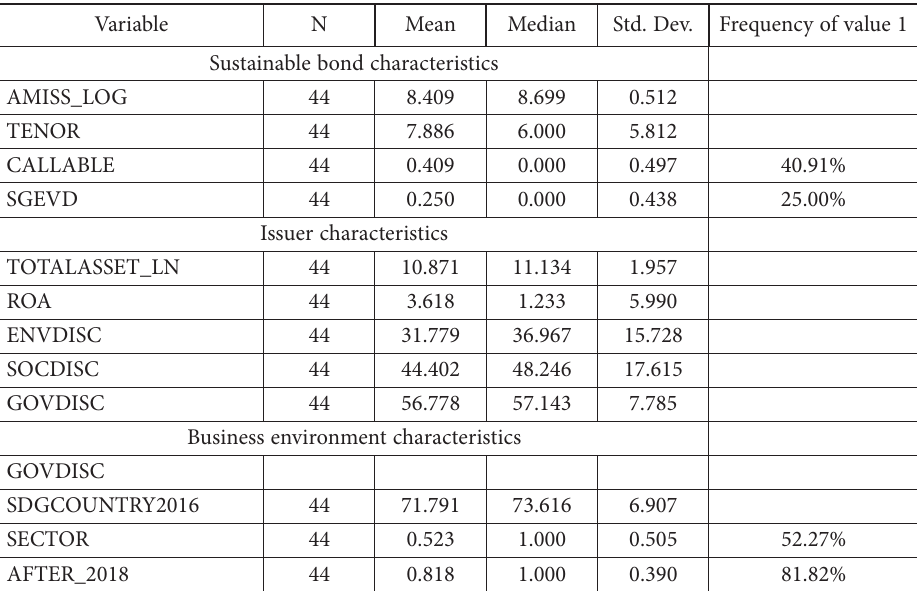
Table 1. Descriptive statistics (source: own design) Variable N Mean